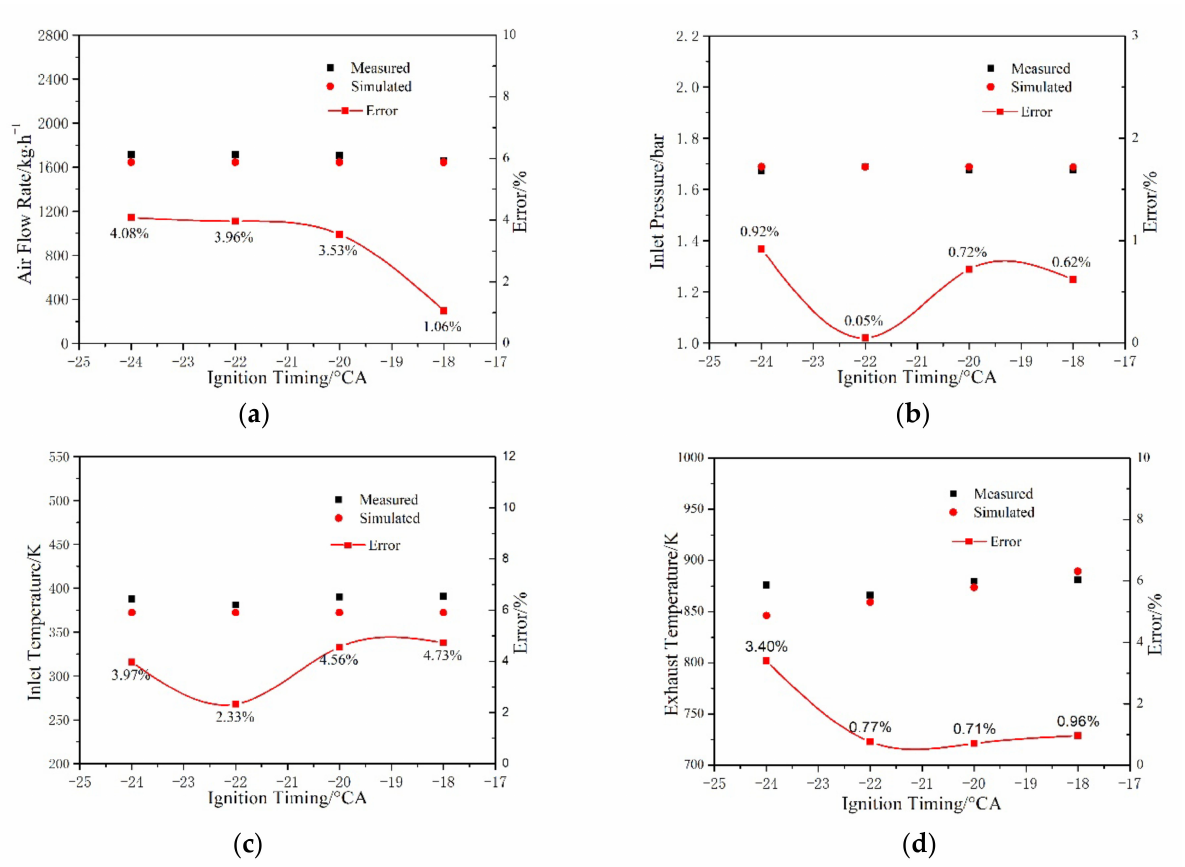
Figure 4. Comparison between simulation and test of intake and exhaust parameters. ( a ) Intake flow ( b ) Intake Pressure( c ) Intake temperature ( d ) Exhaust temperature.